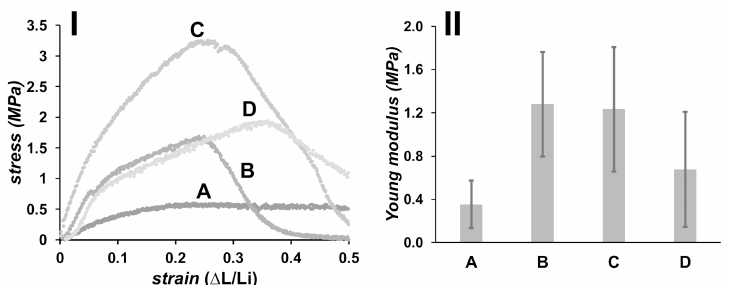
Figure 4. Tensile stress–strain plot ( I ), and Young modulus for PLA-based fibers ( II ): (A) PLA10, (B) PLA/PEG, (C) PLA/PEG/2.5HA, and (D)